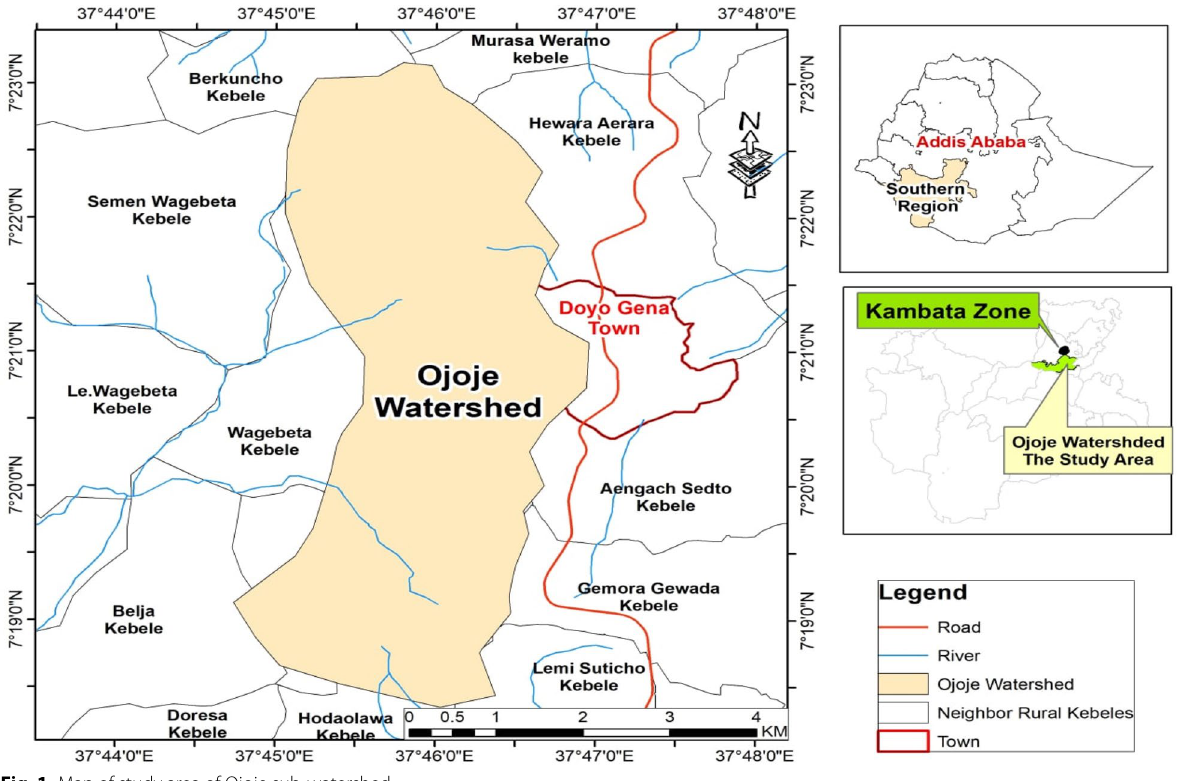
Fig. 1 Map of study area of Ojoje sub-watershed